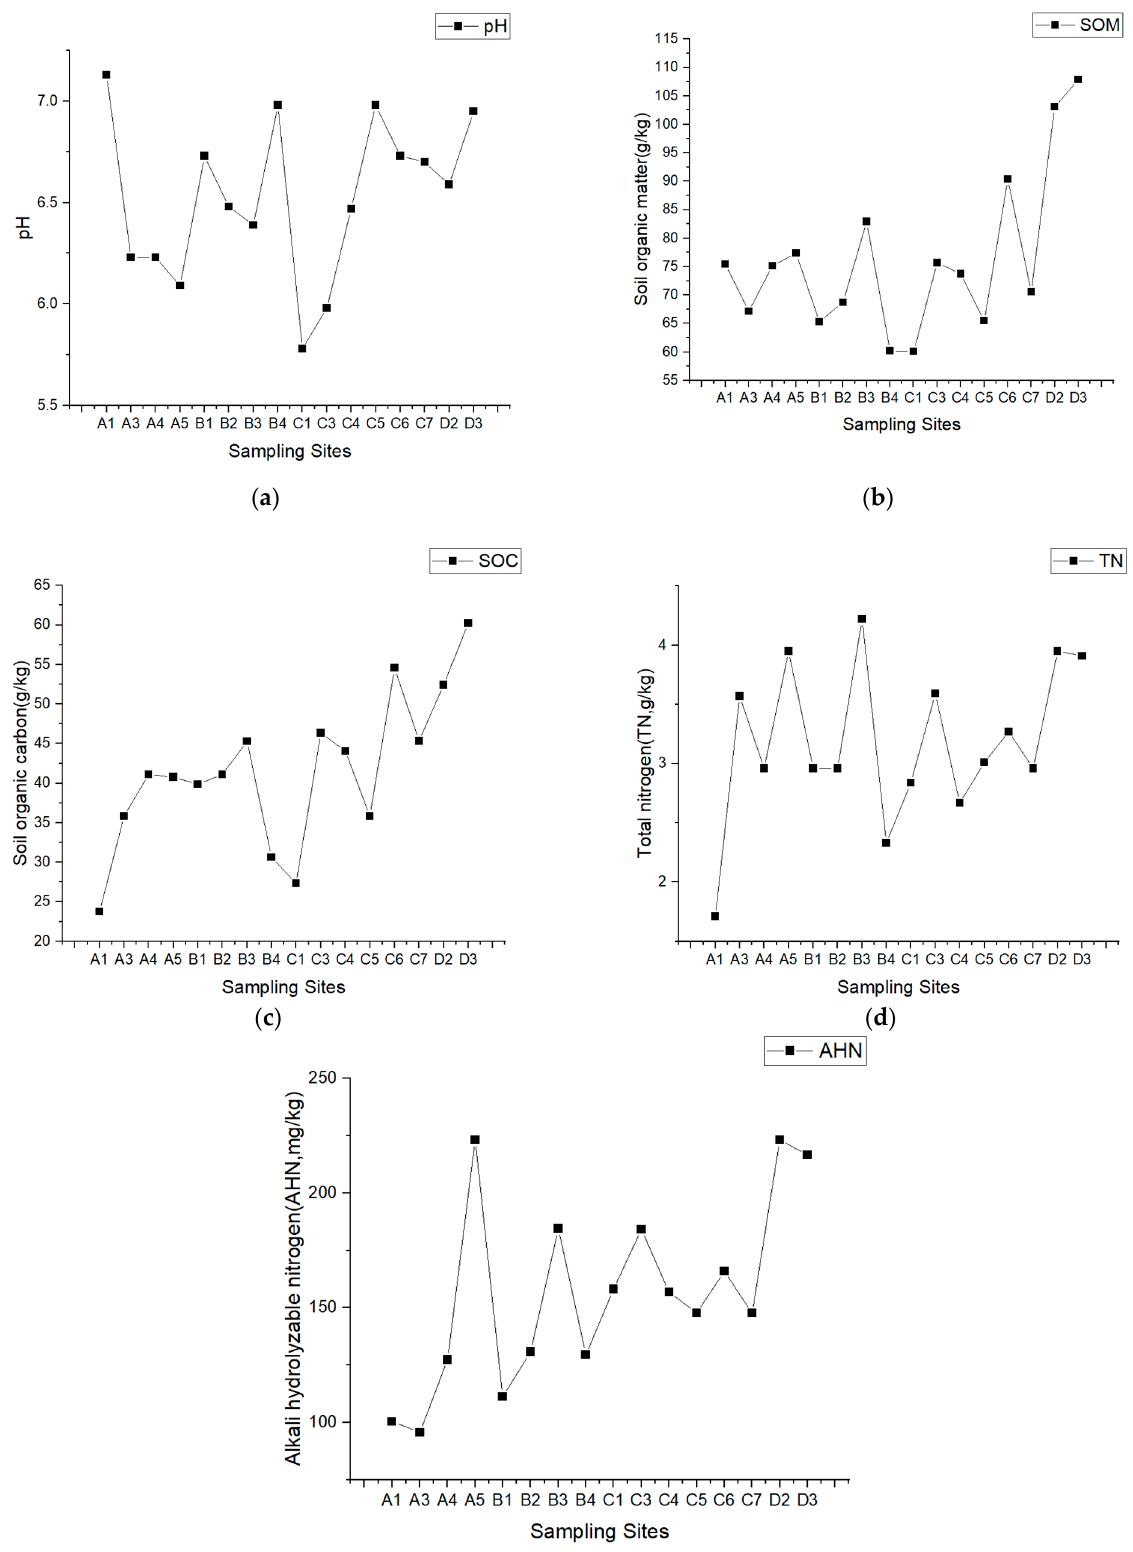
Figure 3. The status map of pH, SOM, SOC, TN, and AHN of 16 sampling sites. ( a ) pH; ( b ) soil organic matter (SOM); ( c ) soil organic carbon (SOC); ( d ) total nitrogen (TN); and ( e ) alkali-hydrolyzable nitrogen (AHN). Table 3. Correlation analysis of pH, SOM, SOC, TN, and AHN.